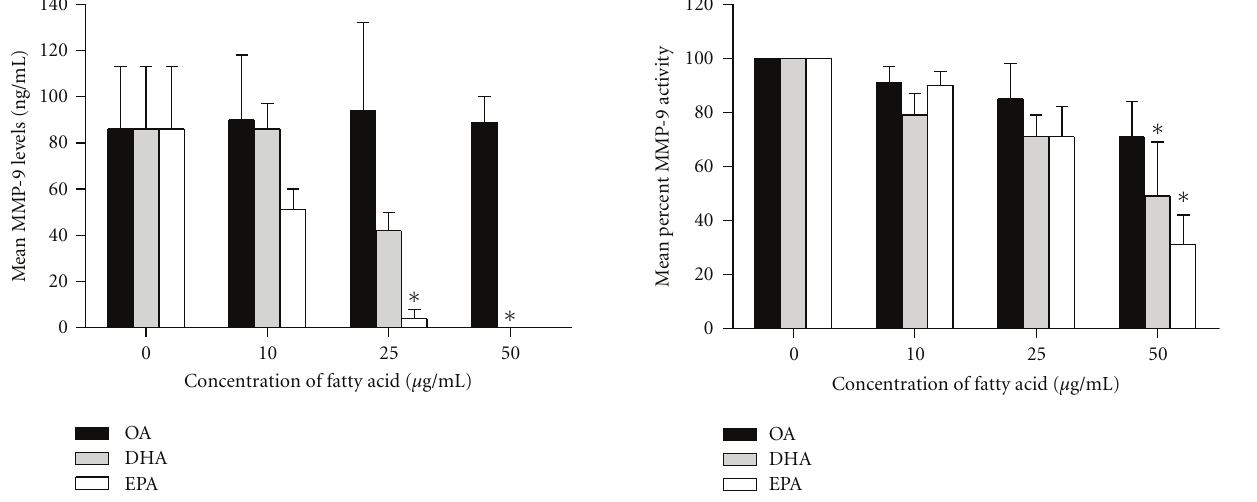
Figure 1: Mean MMP-9 protein levels secreted from PBMC. PBMC from three di ff erent normal controls. MMP-9 levels secreted from ConA-stimulated PBMC is decreased following treatment with DHA and EPA when compared to an untreated ConA-stimulated PBMC control. OA served as an oil control and showed no sig- nificant decrease in MMP-9 levels at any concentration. PBMC were pretreated for 2hr in the presence of 10, 25, and 50 μ g/mL of one of the following, DHA, EPA, or OA. Cells were then stimulated with ConA and supernatants were collected to determine MMP-9 levels by ELISA. Error bars represent standard error (SE). ∗ Significant decrease compared to control ( P ≤ 0 . 05).